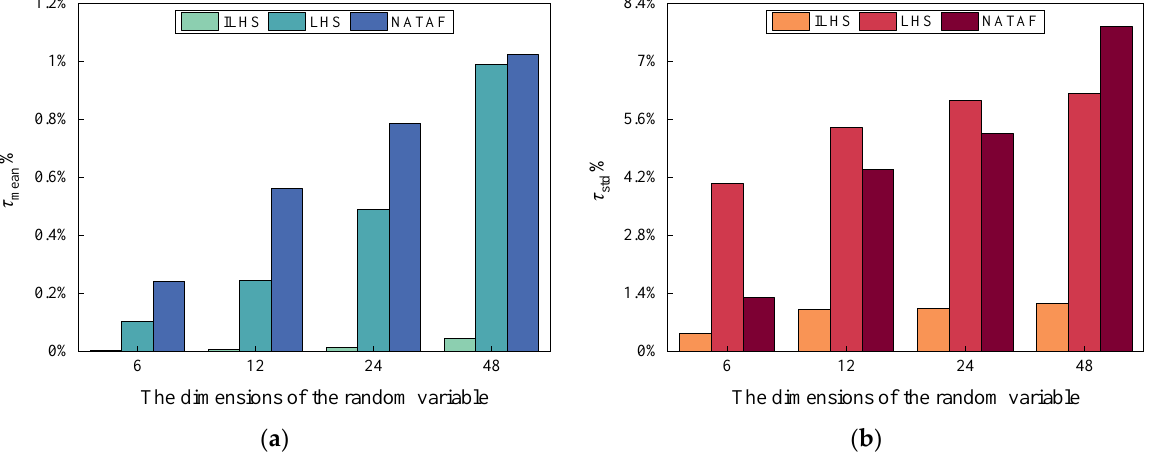
Figure 14. Comparison of ( a ) the mean error and ( b ) the standard deviation error of the AC-side bus voltage phase angles at the converter stations under different random variable dimensions.